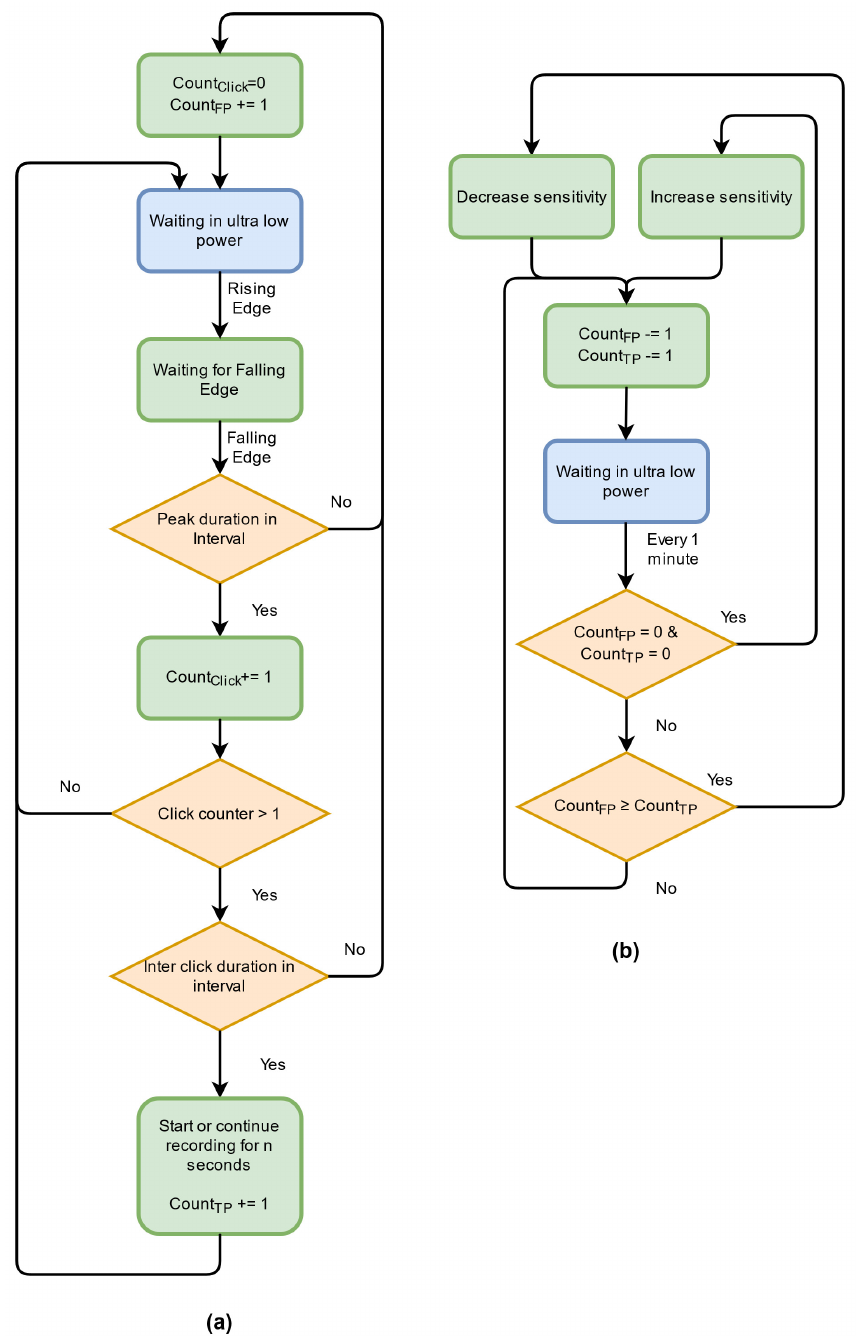
Figure 14. Cetacean click detection state machine ( a ), and automatic gain control state machine ( b